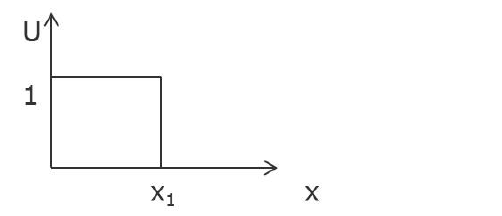
Figure 7: A requirement is unexamined u A (0) = 1 (or e A (0) = 0) for x A = 0 and examined e A ( x A ) = 1 (or u A ( x A ) = 0) at x A = x 1 .